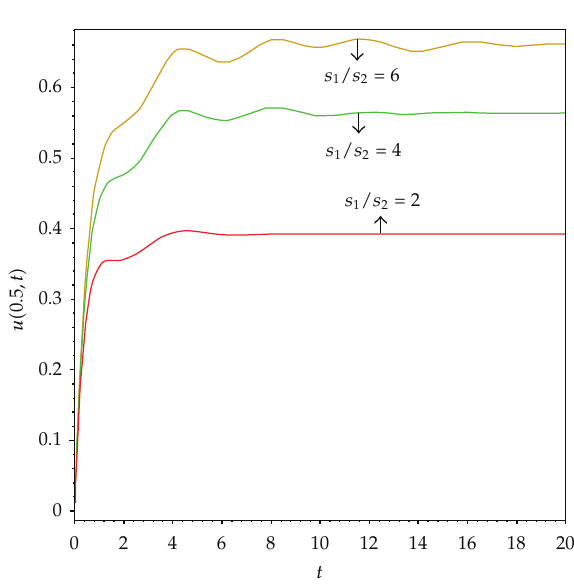
Figure 4: The e ff ect of the elasticity on the centerline velocity profile for μ 1 (cid:8) 10 and h (cid:8) 1 for permeable wall (cid:6) α (cid:8) 1 (cid:7)